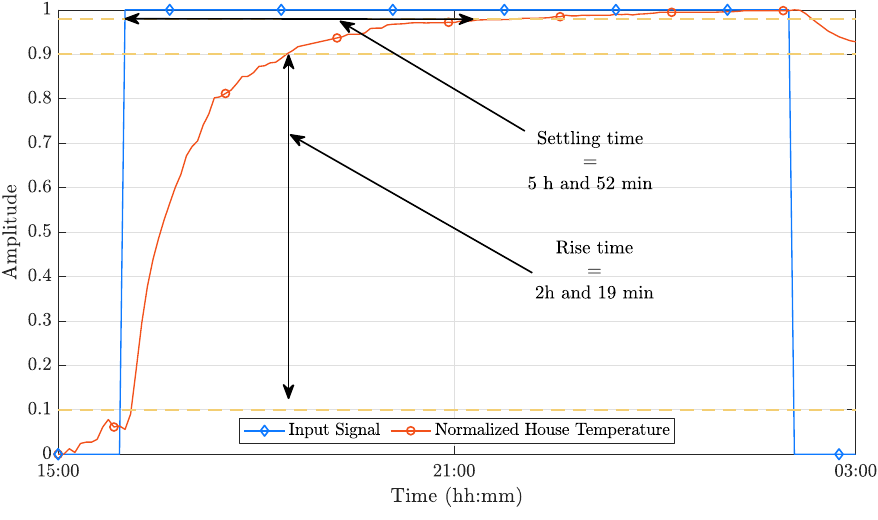
Figure 9. Step response of the system